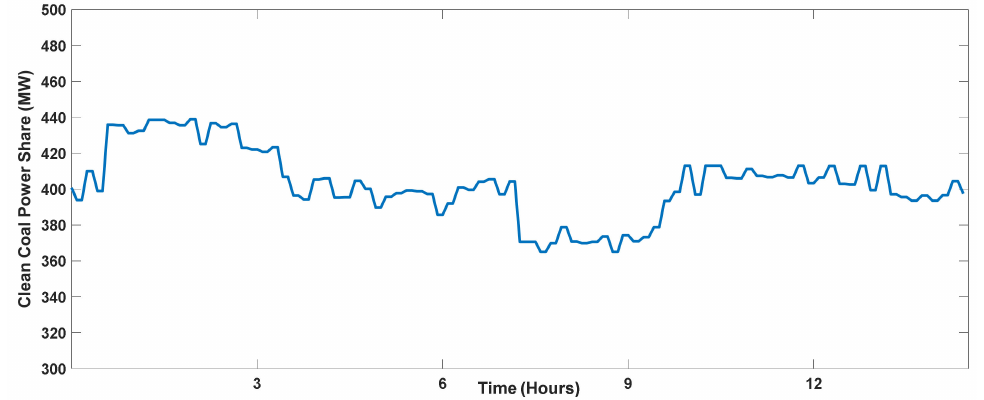
Figure 11. Output power share of the clean coal SC power plant. Figures 12 and 13, respectively, show the manipulated inputs and the output shared by the GT plant, where the inputs are the pilot valve, natural gas valve (NGCTRL), and the compression ratio (COMPPO), are maintained within their constraints, those restricted by the 250-MW dual-fuel gas turbine (GT).